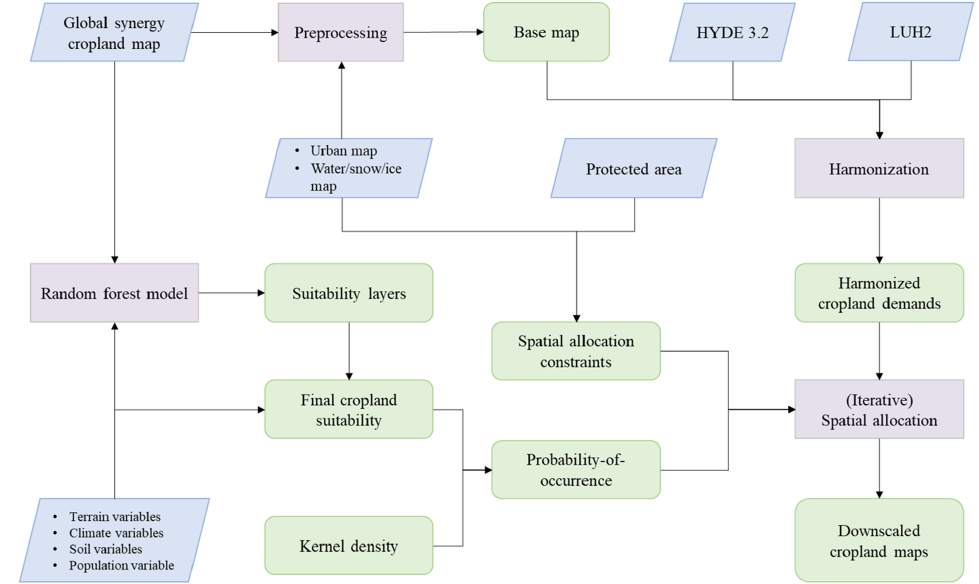
Figure 1. The framework of producing the 1km global cropland dataset for 10000BCE–2100CE.